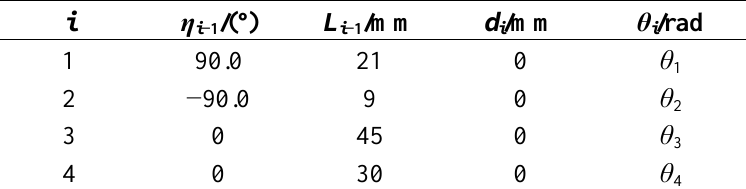
Table 1. The D-H parameters of the robot